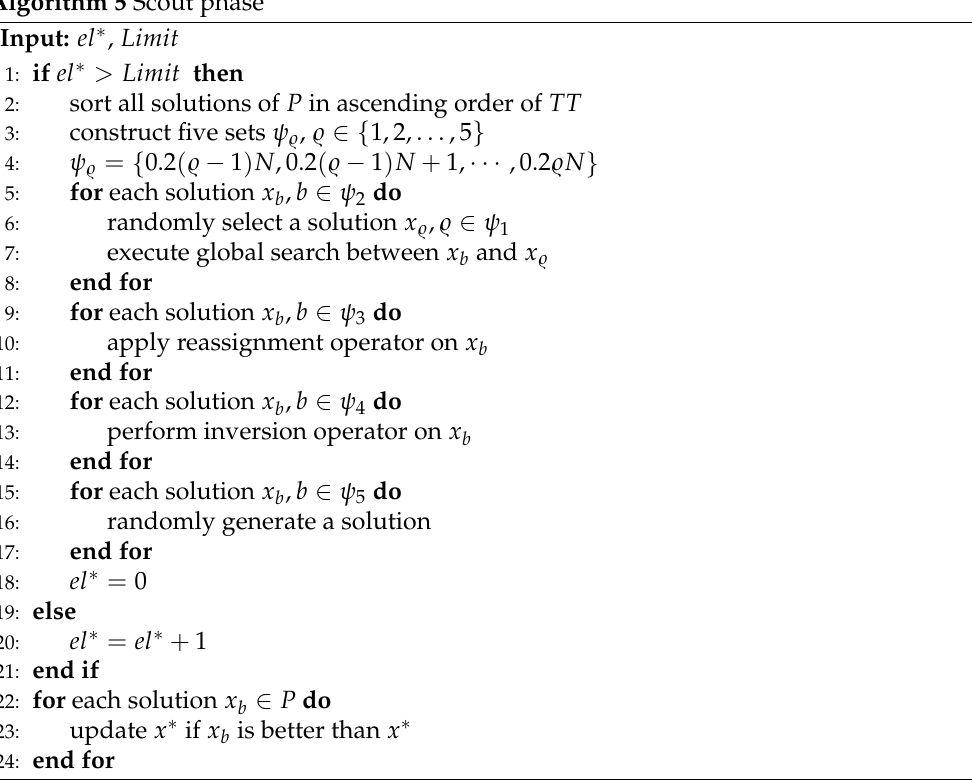
Algorithm 5 Scout phase